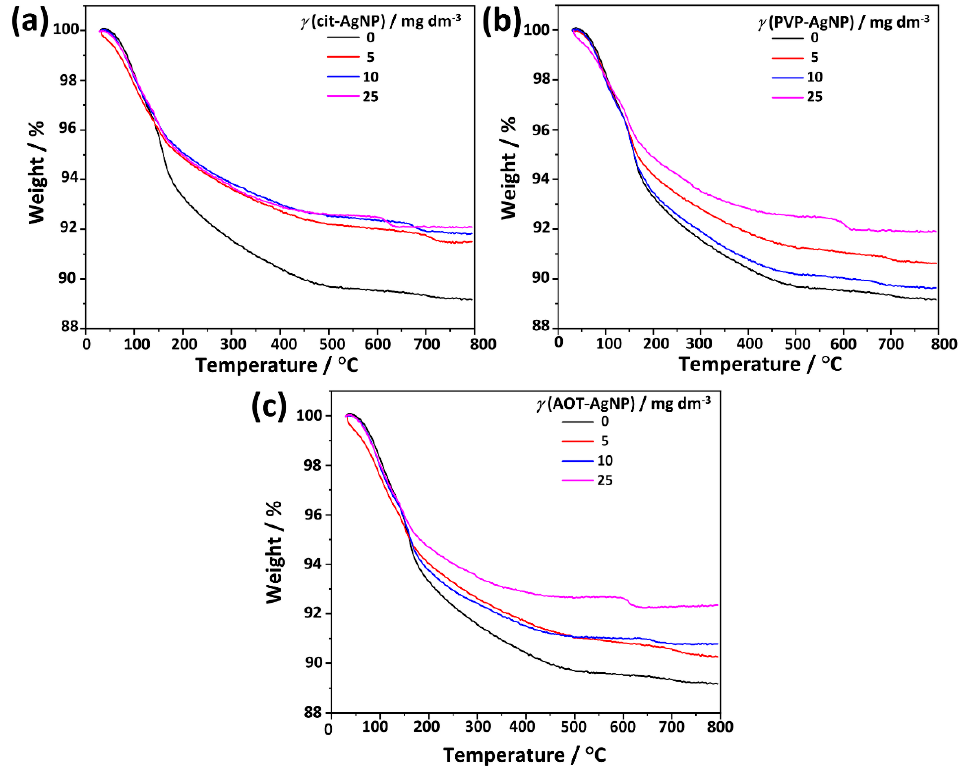
Figure 9. TGA curves of the precipitates obtained after 60 min reaction time in the presence of different concentrations of silver nanoparticles (AgNPs) stabilized with ( a ) citrate (cit-AgNPs), ( b ) poly(vinylpyrrolidone) (PVP-AgNPs), and ( c ) sodium bis(2-ethylhexyl) sulfosuccinate (AOT-AgNPs). c (CaCl 2 ) = c (Na 2 HPO 4 ) = 4 · 10 − 3 mol dm − 3 , pH 7.4, 25 °C.